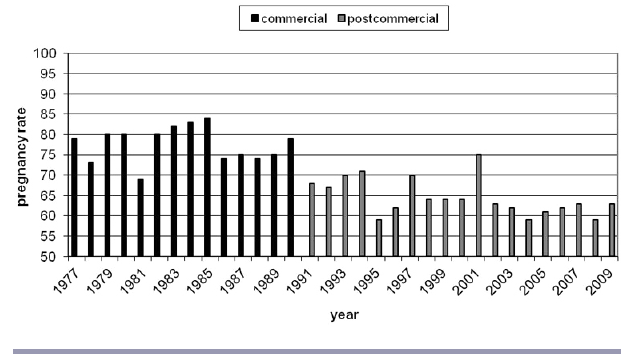
Fig. 5 . Pregnancy rates of the Taimyr reindeer population 1977-2010. All data based on combination of composition count surveys during calving and animals collected in the field.